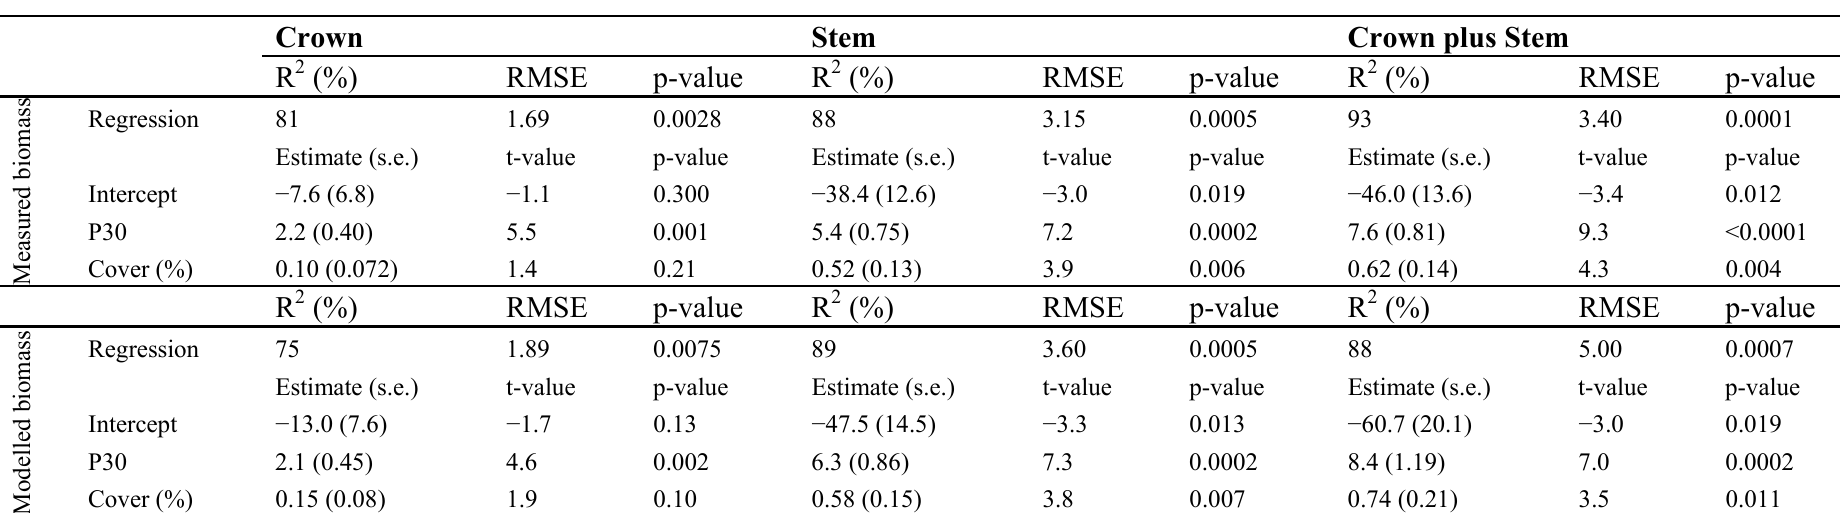
Table 6. Multiple regression coefficients between radiata pine biomass carbon (t/ha of crown, stem, and crown plus stem) and LiDAR percentile height (P30) and cover (%) based on all returns. The regressions are based on 10 plots with measured and modelled biomass carbon (0.5 m ground and canopy cut-off heights). The model R 2 , RMSE, and p-values are given for each model.